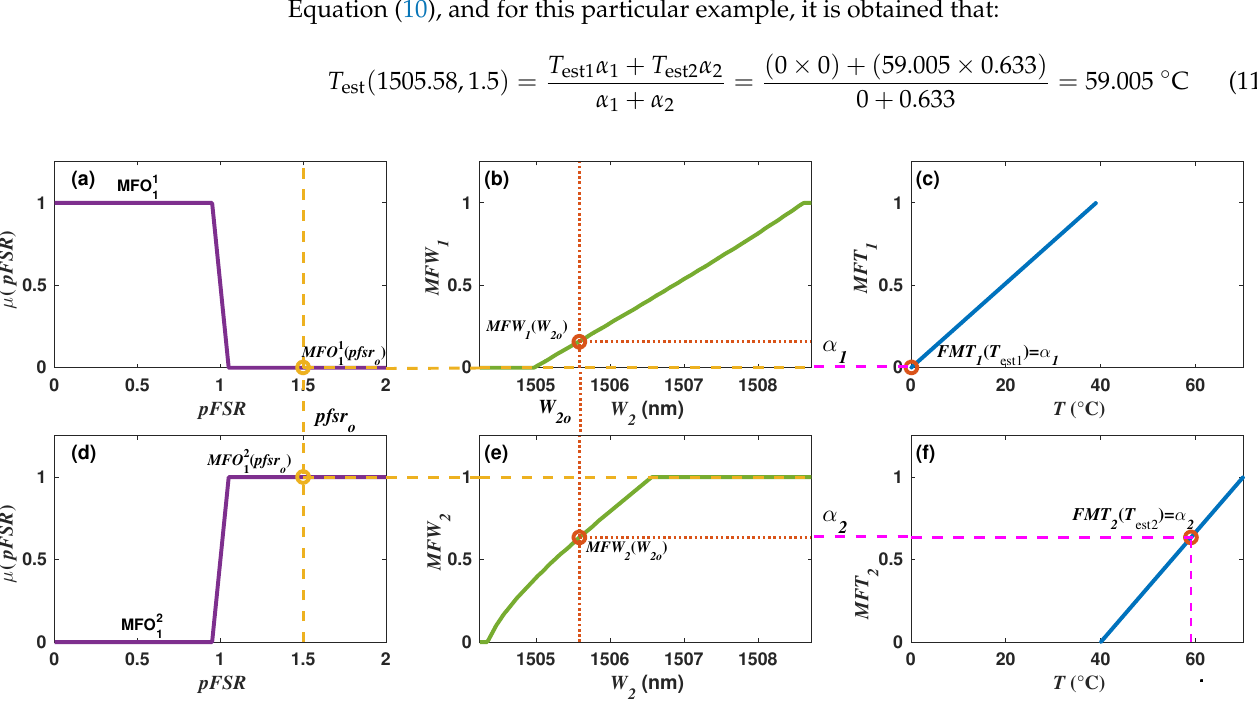
Figure 7. Example of the membership functions built with Algorithm 3 for the case when W 2 is considered as the input and the inference mechanisms procedure. ( a , d ) membership functions used to fuzzificate the input variable pFSRo ; ( b , e ) membership functions used to fuzzificate the input variable W 2 , for the particular value of ( W 2 o ); at the right shows the corresponding firing levels for this case ( α 1 and α 2 ); ( c , f ) membership functions MFT 1 and MFT 2 used to evaluate the consequences of the two fuzzy rules.